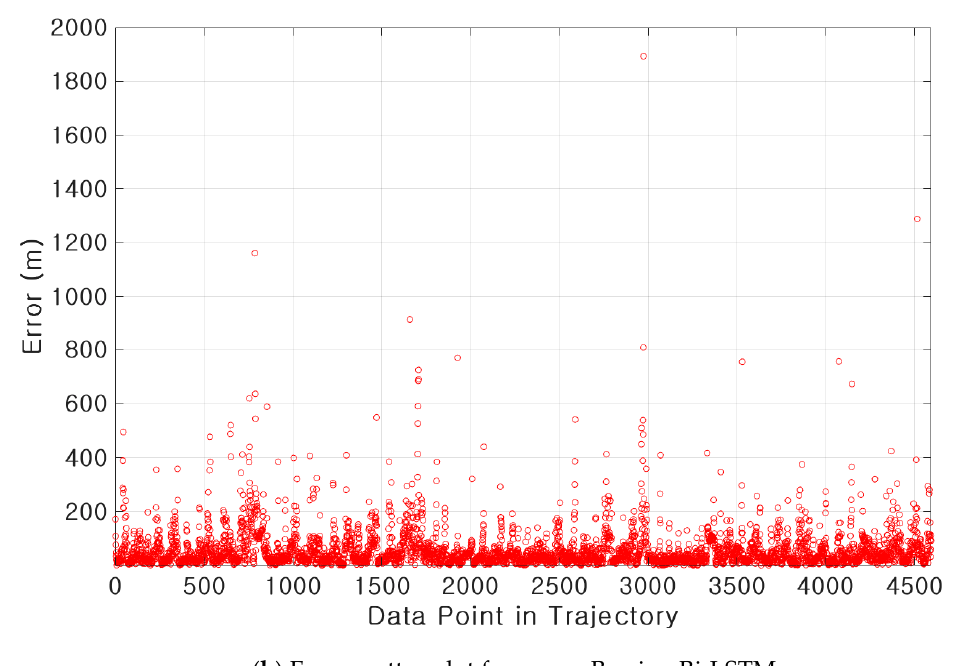
( h ) Error scatter plot for group B using Bi-LSTM.